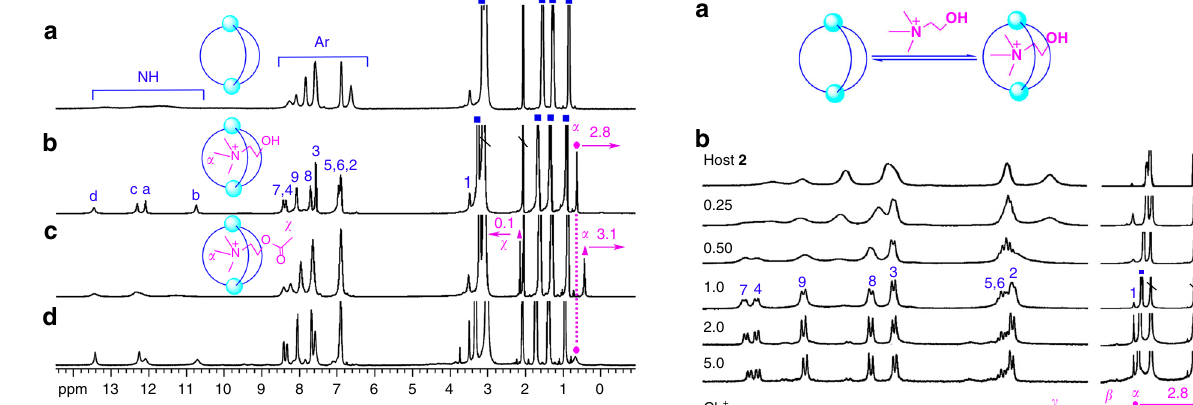
Fig. 3 1 H NMR spectra demonstrating complexation of different guests by host 2 . a 1 H NMR (acetone- d 6 /1.5% H 2 O, 400 MHz) spectra of host 2 alone and in the presence of 1 equiv. of b Ch • Cl, c ACh • Cl, and in coexistence of 1 equiv. of d Ch • Cl, ACh • Cl, LC, and GB (blue squares TBA + , Fig. 4 Studies of the complexation process of choline by host 2 . a Scheme